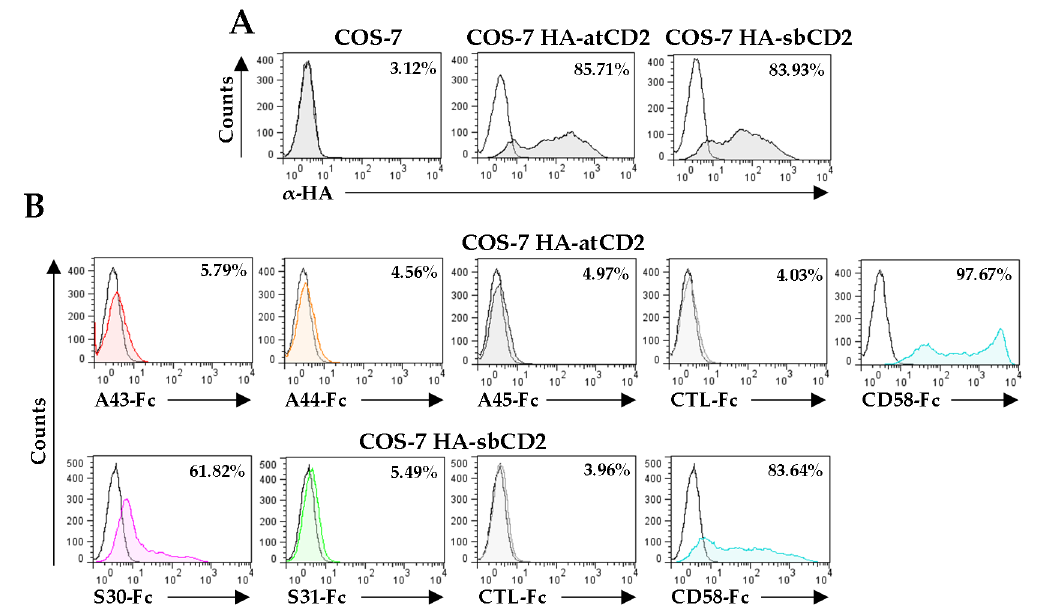
Figure 7. Analysis of the binding capacity of A44, A45, S30, and S31 to host CD2. ( A ) Flow cytometry analysis of COS-7 cells non-transfected or transfected with HA-atCD2 or HA-sbCD2 and stained with α -HA mAb (shaded histograms) or an isotype control (open histograms). The percentage of positive cells is indicated in each histogram. ( B ) Interactions of vCD48s with host CD2. COS-7 cells transfected with either HA-atCD2 (upper panels) or HA-sbCD2 (bottom panels) were incubated with 8 µ g / mL of A43-Fc, A44-Fc, A45-Fc, S30-Fc, S31-Fc, atCD58-Fc, or an unrelated CTL-Fc fusion protein, as indicated, and then analyzed by flow cytometry (shaded and colored histograms). Open histograms represent isotype controls. The percentage of positive cells is indicated in each histogram.